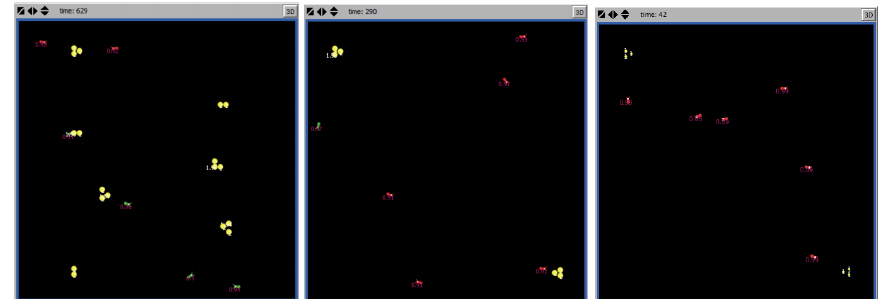
Figure 2. Screenshots for all three world conditions. Easy conditions ( left ) have an abundance of food resources, Challenging conditions ( middle ) have sparse resources on the outside of the world, and Super Challenging ( right ) conditions are the same as Challenging, but with less nutritional